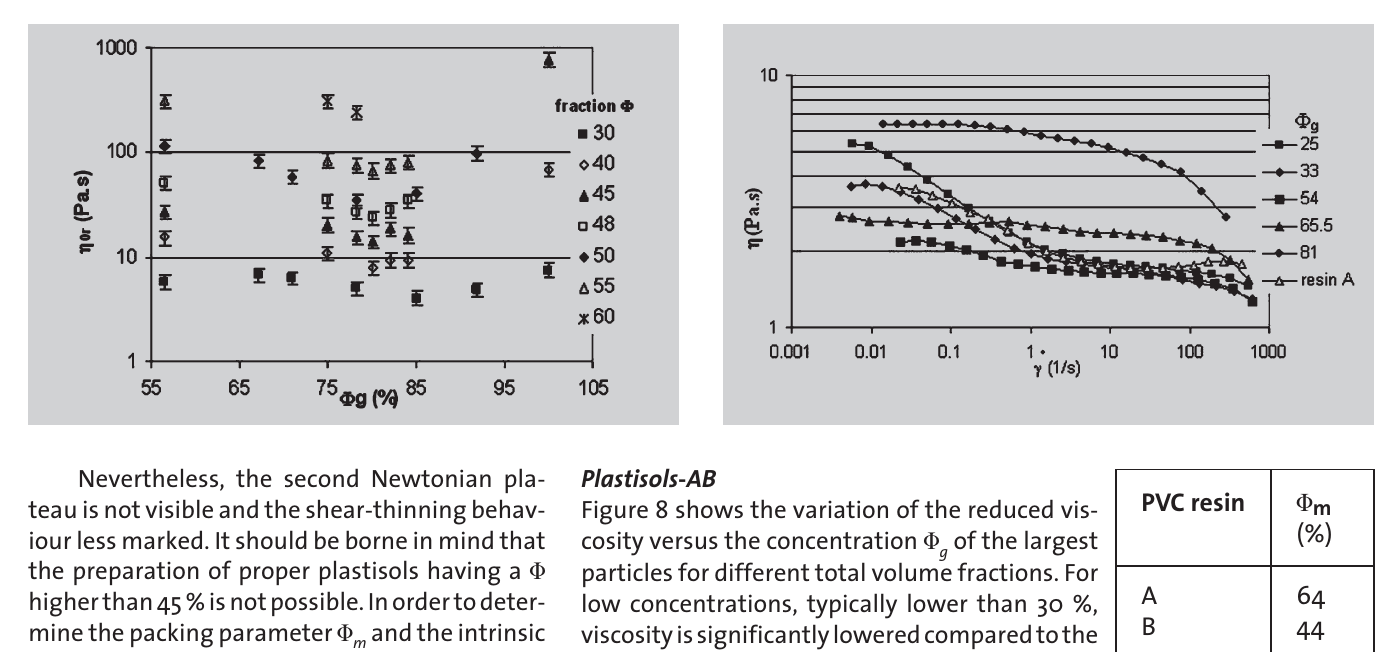
Figure 8 (left): Rheological curve for plasti- sols-AB - F = 50%. Variation of the viscosity versus shear rate at room temperature for different F . g Figure 9: Plastisols-AB: Variation of the reduced zero shear vis- for cosity as a function of F g different F . Table 2: Maximum packing fraction of each resin according to the best fit of the Krieger- Dougherty